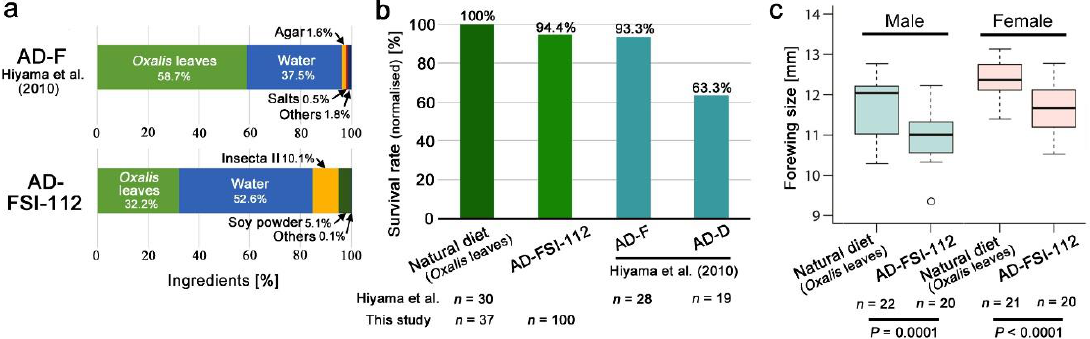
Figure 1. Evaluation of the artificial diet AD-FSI-112. ( a ) Ingredients of the artificial diets AD-F, according to Hiyama et al. (2010) [43], and AD-FSI-112. Ingredients are shown in weight proportions. ( b ) Survival rates (normalised). Data for AD-F and AD-D were obtained from Hiyama et al. [43]. ( c ) Forewing size. p -values are shown (Student’s t -test).